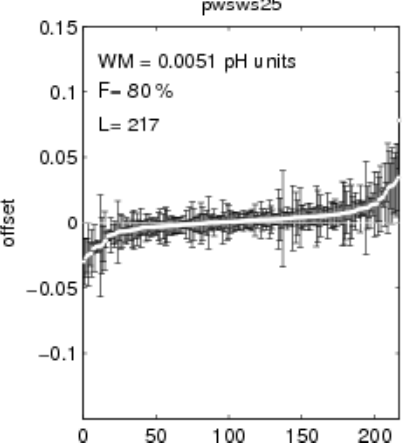
Figure 26. Sorted o ff sets calculated for the crossovers in the CA- RINA data after adjustments have been applied. WL: the weighted mean of the o ff sets (see text); F : the percentage of o ff sets in- distinguishable from 0 within their uncertainty; L : the number of